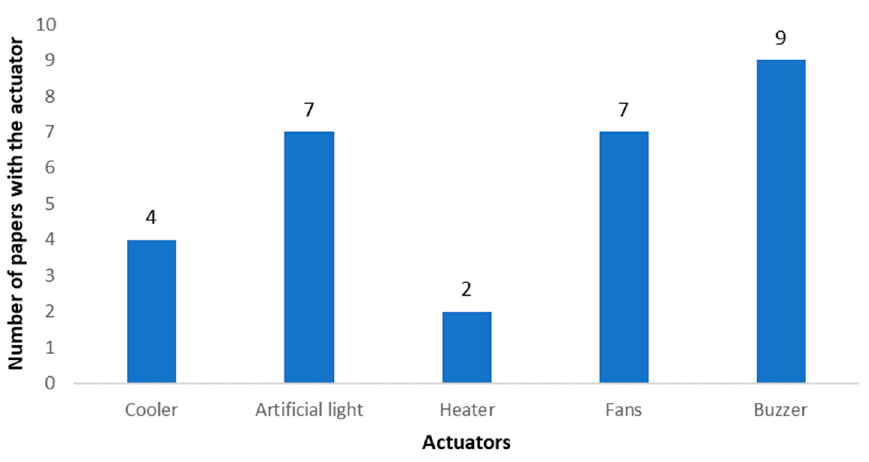
Figure 20. Most utilized actuators.